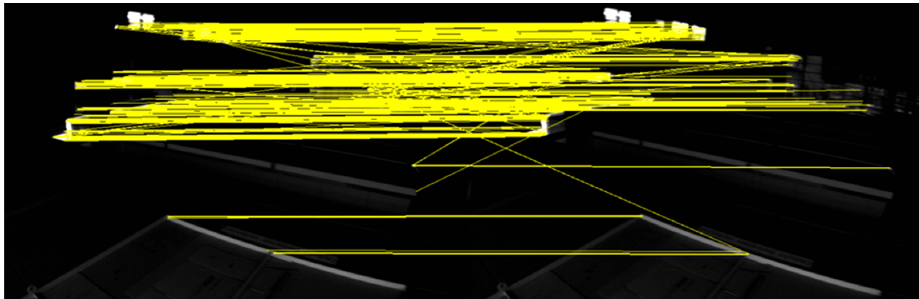
Figure 9. Image with insufficient illumination.